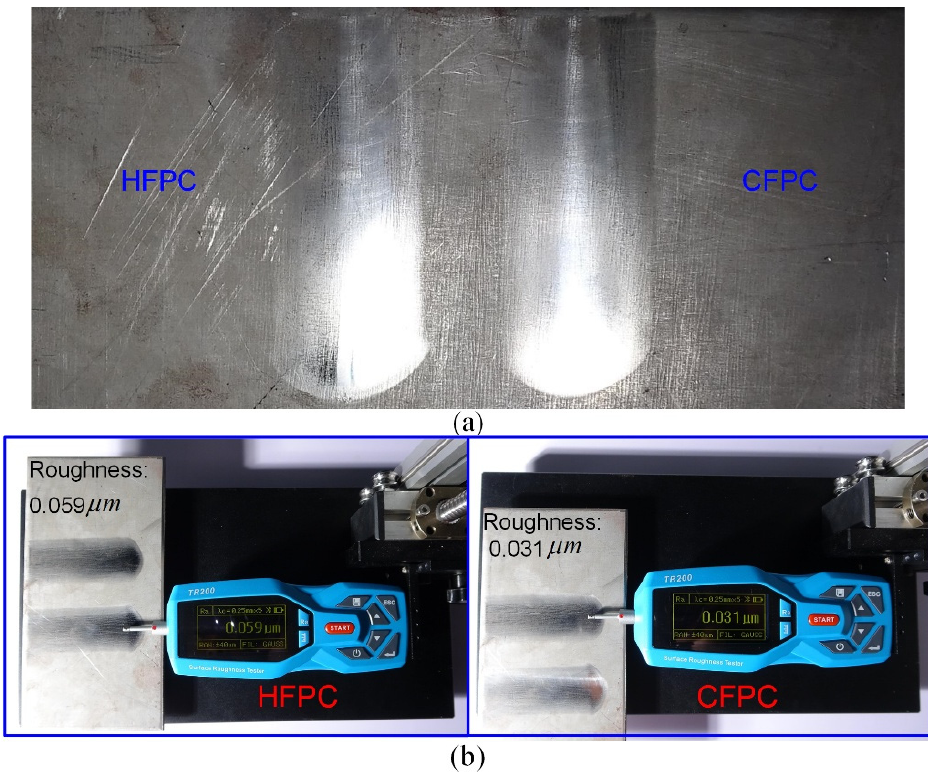
Figure 16. ( a ) Grinding experiment results and ( b ) measured roughness from the HFPC (left photo- graph) and proposed CFPC (right photograph) methods.